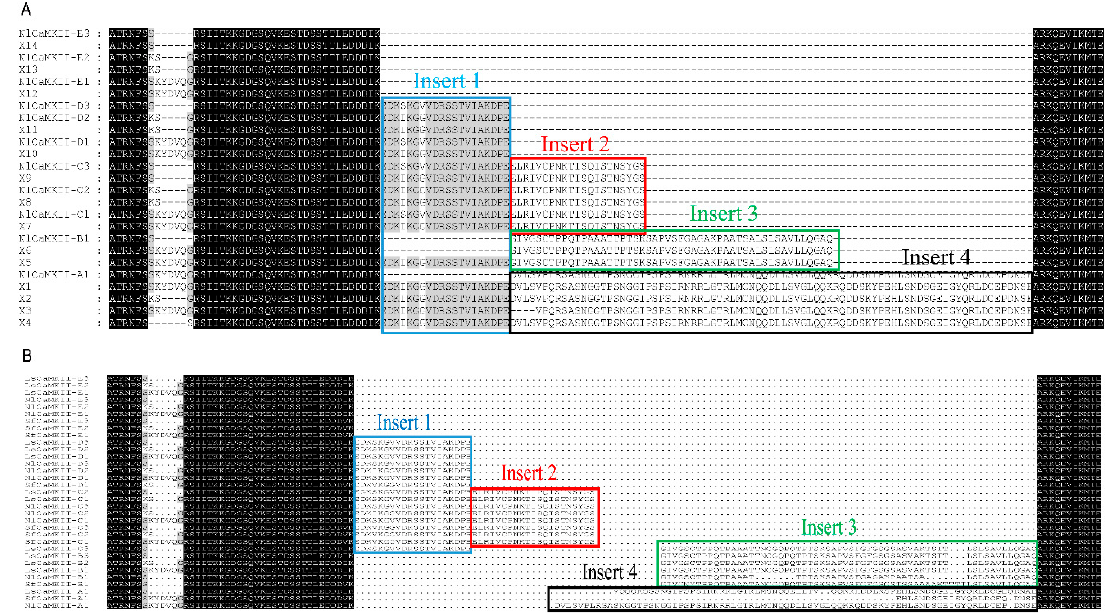
Figure 3. ( A ) Partial multiple alignment of CaMKII isoforms cloned by RT-PCR and fourteen predicted transcript variants (X1–X14) in N. lugens . ( B ) Partial multiple alignment of CaMKII isoforms cloned from N. lugens , S. furcifera , and L. striatellus . The different inserts are boxed with different colors.